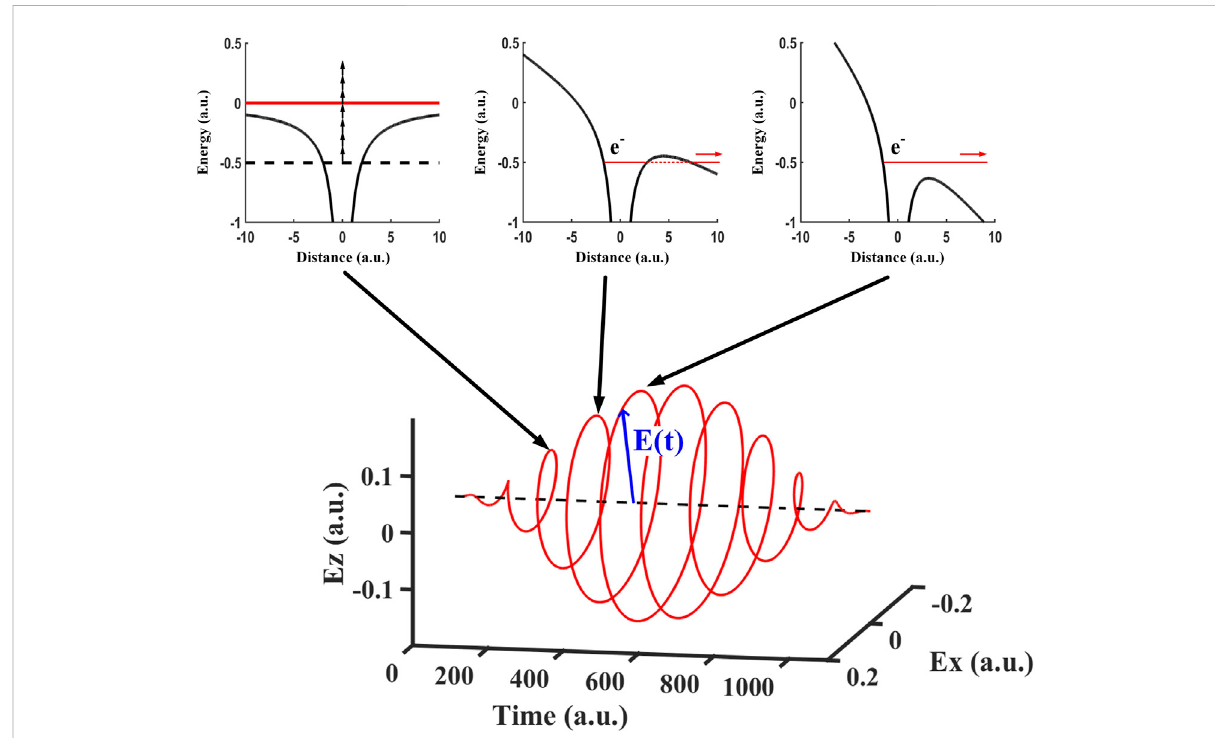
FIGURE 1 Theelectric fi eldofacircularlypolarizedpulselaserwiththepeakelectric fi eldstrengthof0.2 a.u.Threeinsetsrepresentthreedifferentkindsof ionization and mark the corresponding electric fi eld strength. The blue arrow represents the instantaneous electric fi eld